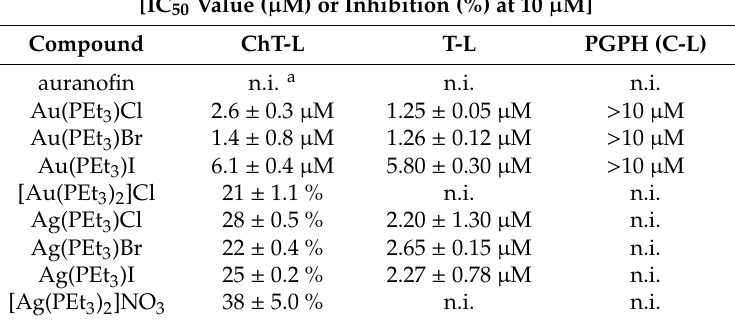
Table 2. Inhibition (IC 50 values or % of inhibition at 10 µ M) of the chymotrypsin-like (ChT-L), trypsin-like (T-L) and peptidyl-glutamyl peptide-hydrolyzing (PGPH or caspase-like C-L) activities of human 20S proteasome by panel compounds. Inhibition includes standard deviation from three independent experiments, each performed in duplicate.